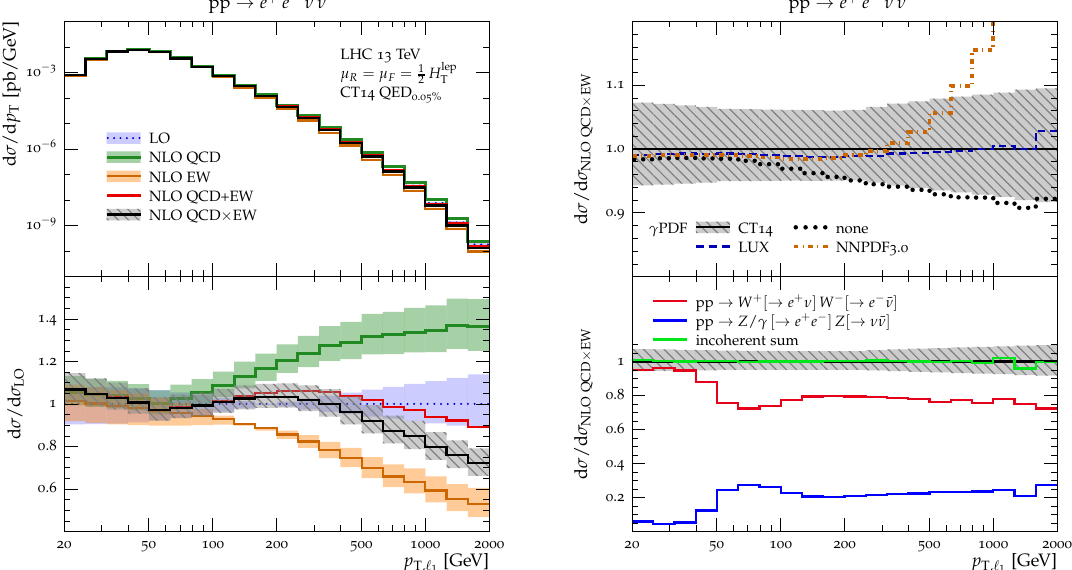
+ e (cid:0) (cid:23) (cid:22) (cid:23) T ;‘ 1 , for pp ! e e + e (cid:0) (cid:23) (cid:22) (cid:23) and !